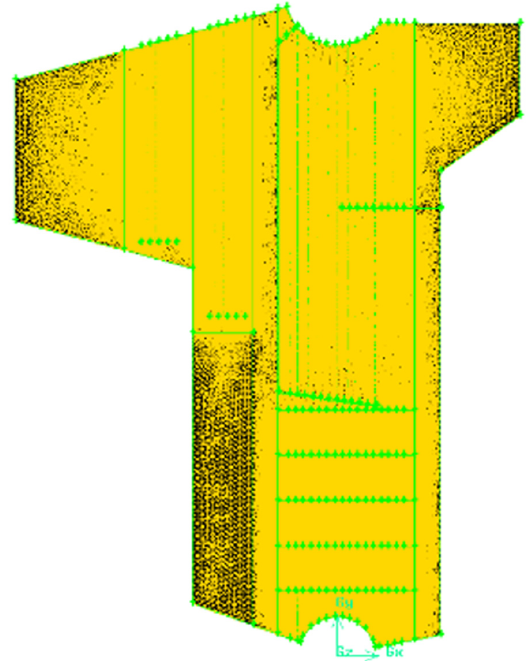
Figure 2. Block mesh of the convection bank in a D-type boiler.